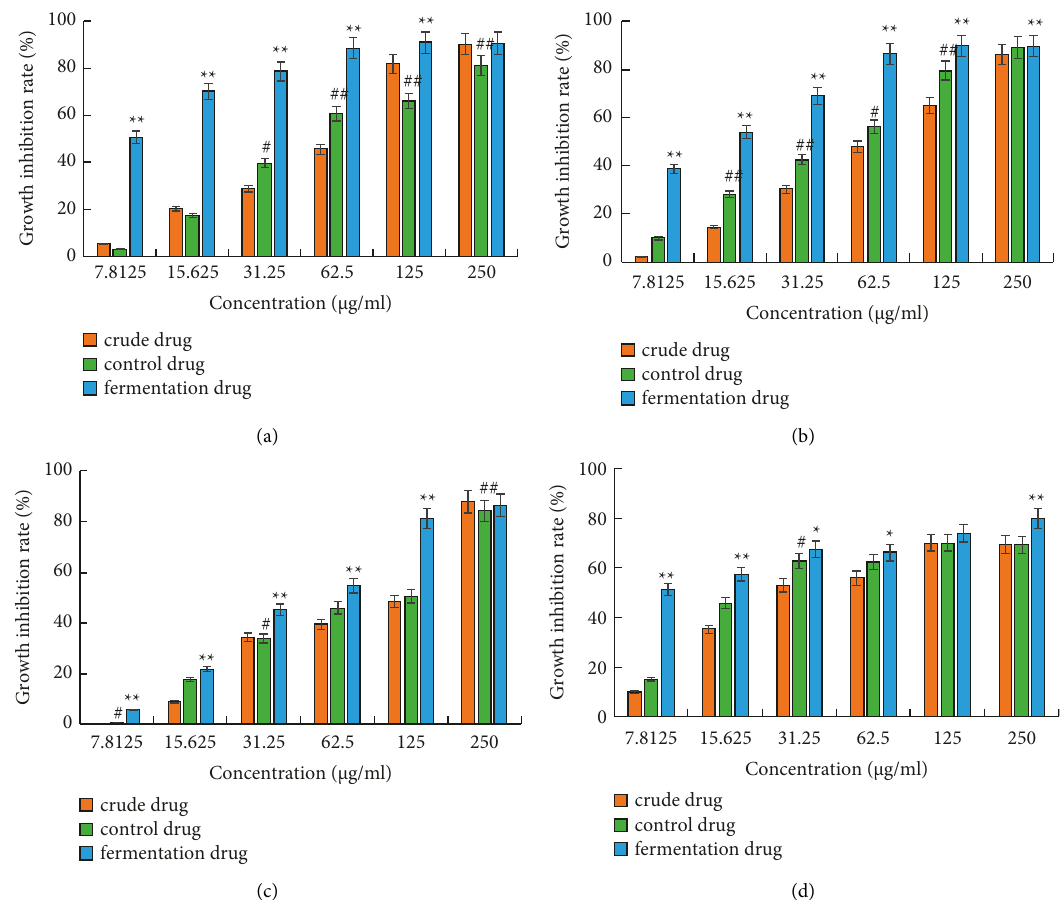
Figure 2: Inhibition of proliferation in different cancer cells by different concentrations of crude, control, and fermentation drugs: (a) effect on the viability of liver cancer HepG2 cells, (b) effect on the viability of gastric cancer BGC823 cells, (c) effect on the viability of cervical cancer HeLa cells, and (d) effect on the viability of lung cancer A549 cells. The values are presented as the mean ± SD ( n � 6). ∗ p < 0 . 05 and ∗∗ p < 0 . 01 versus fermentation drug group and # p < 0 . 05 and ## p < 0 . 01 versus control drug